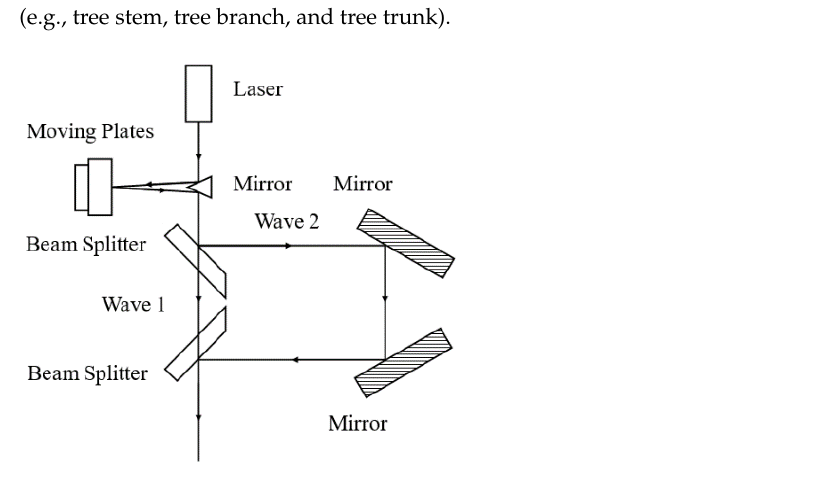
Figure 3. Basic components of a laser Doppler interferometer. The laser beam is directed at the surface of interest, based on which the vibration amplitude and frequency can be extracted due to the motion of the target